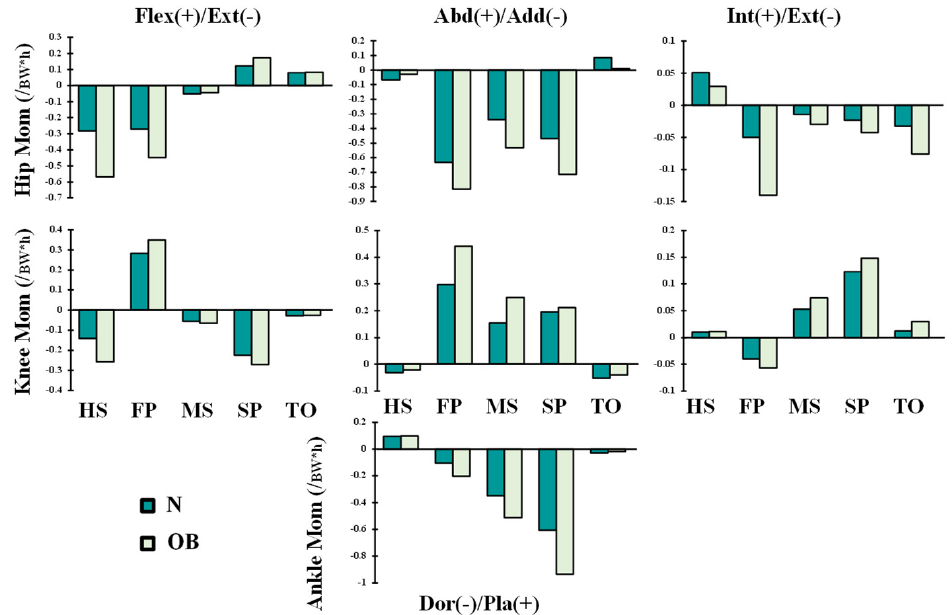
Figure 3. Lower extremity joints’ moments reported as the mean of normal-weight (N) and obese (OB) subjects during the stance phase of gait [43]. Loads were normalized to the body weight (BW = 732.365 N) and height (h = 170 cm) of the female subject of our FE model.